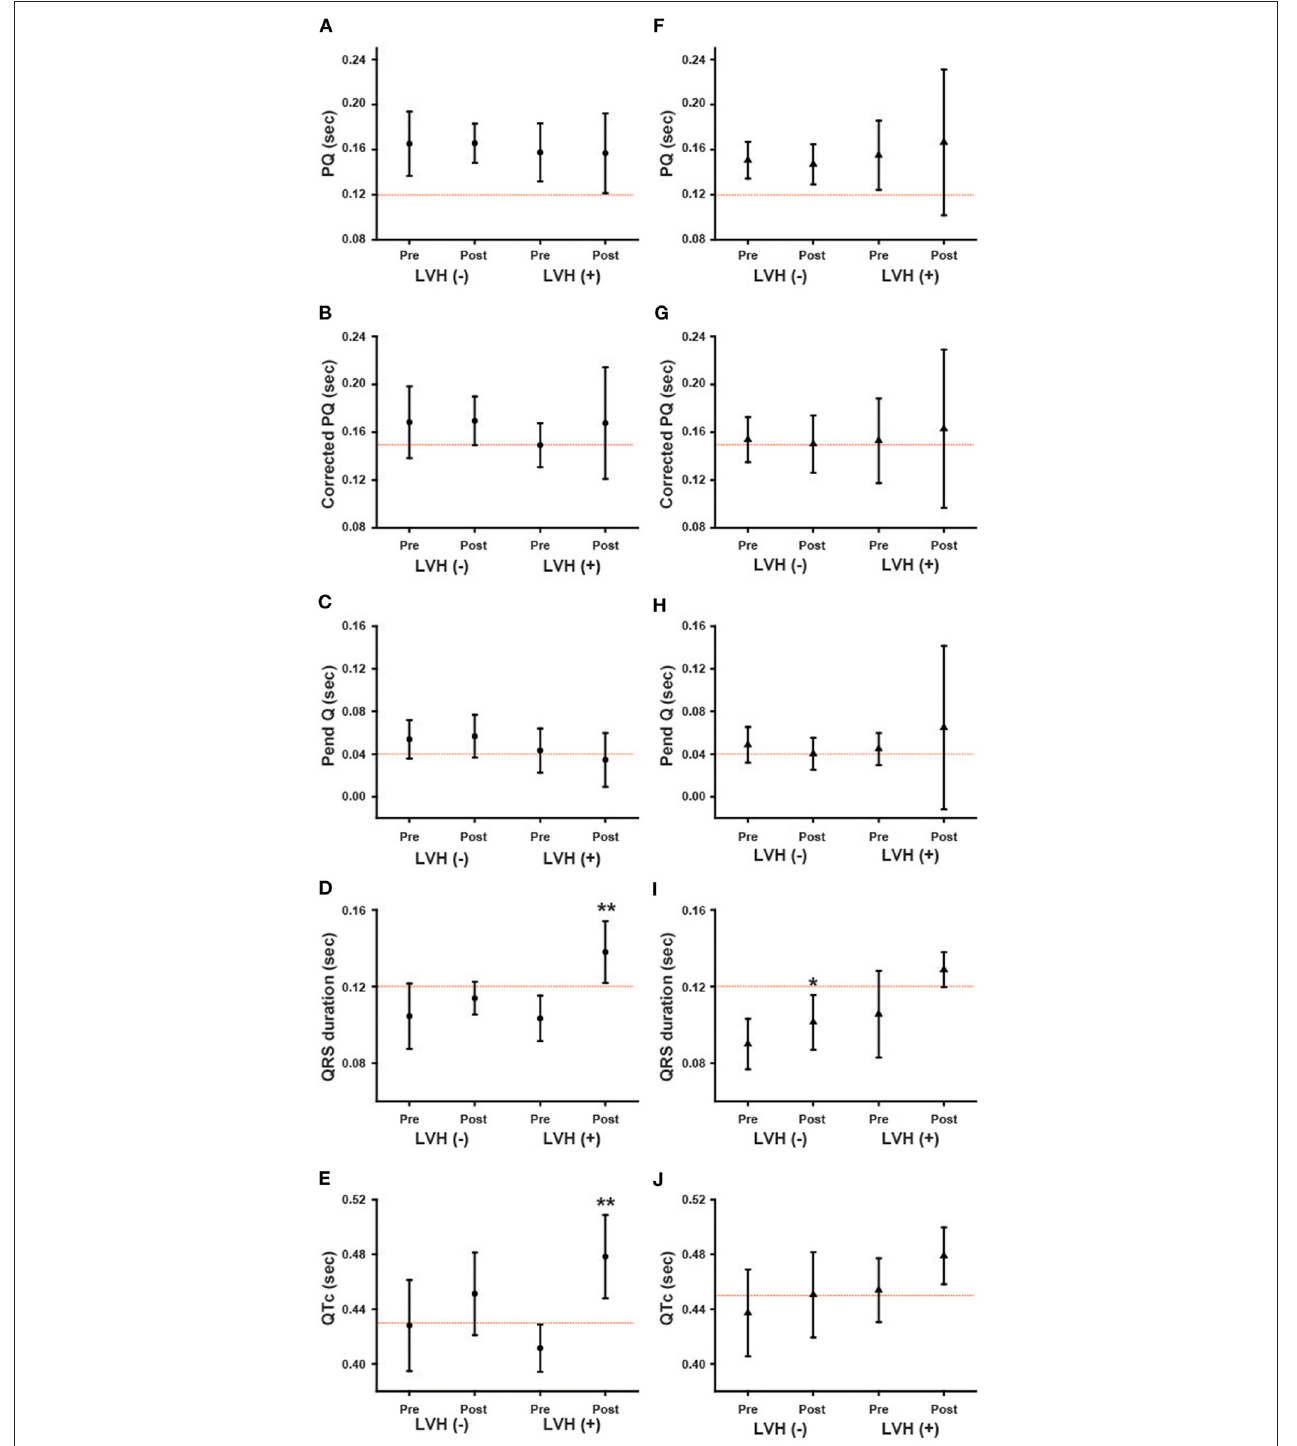
FIGURE 6 | The influence of the left ventricular hypertrophy on the changes in various ECG parameters during long-term enzyme replacement therapy. These figures show the average values of ECG parameters before (Pre) and after (Post) long-term enzyme replacement therapy in the patients without left ventricular hypertrophy [LVH (–)] and in the patients with left ventricular hypertrophy [LVH ( )]. The left columns show the results from male patients (A–E) and the right columns show the + results from female patients (F–J) . The dotted lines indicate the cut-off value for abnormalities in each parameter. Corrected PQ, PQ interval divided by the square root of RR interval; Pend-Q, PQ interval minus P-wave duration in lead II; QTc, QT interval divided by the square root of RR interval. * p < 0.05, ** p < 0.01 comparison between before (Pre) and after (Post) enzyme replacement therapy.